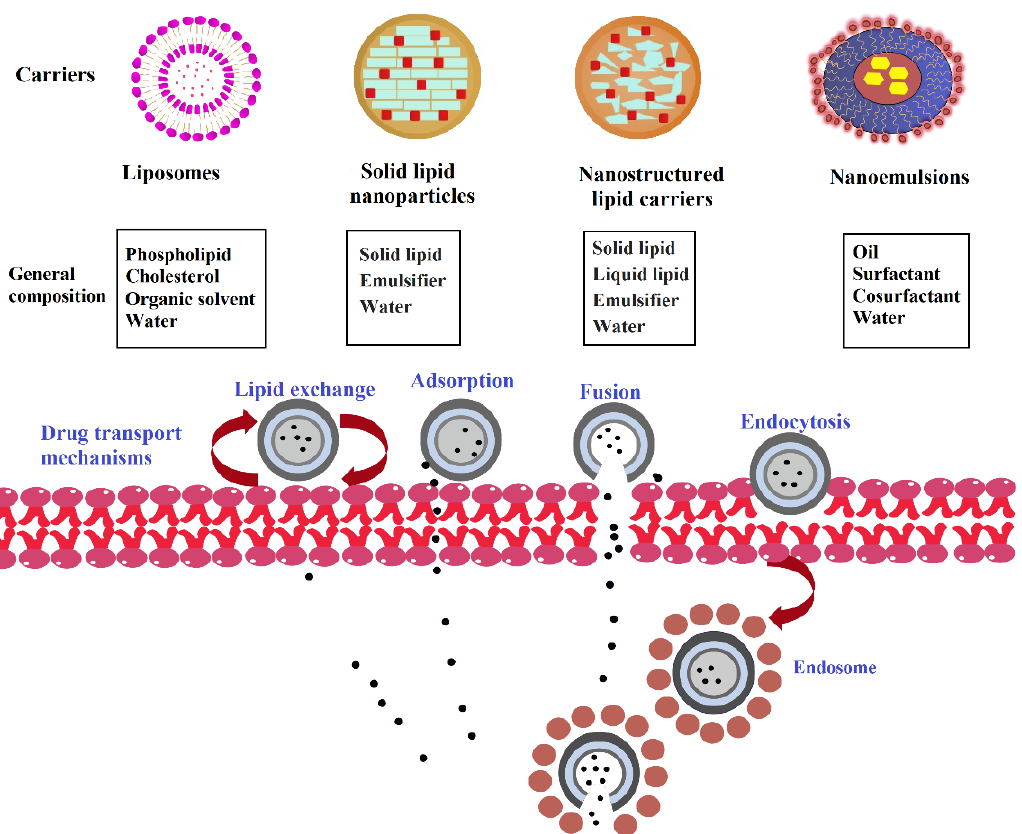
Figure 3. Schematic diagram depicting various drug transport mechanisms of lipid nanoparticles in the human eye.